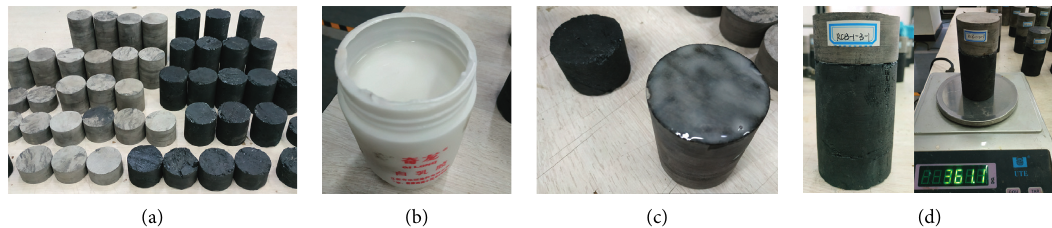
Figure 2: Coal and rock combined body manufacturing process. (a) Coal and rock samples. (b) White latex adhesive. (c) The adhesive applied to the interface. (d) Samples labeling and weighing.